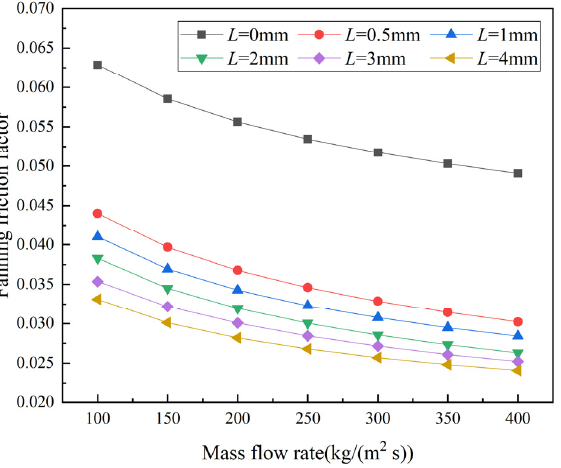
Figure 5. Fanning friction factor values of PCHEs at different mass flow rates for different offset distances of inserted straight